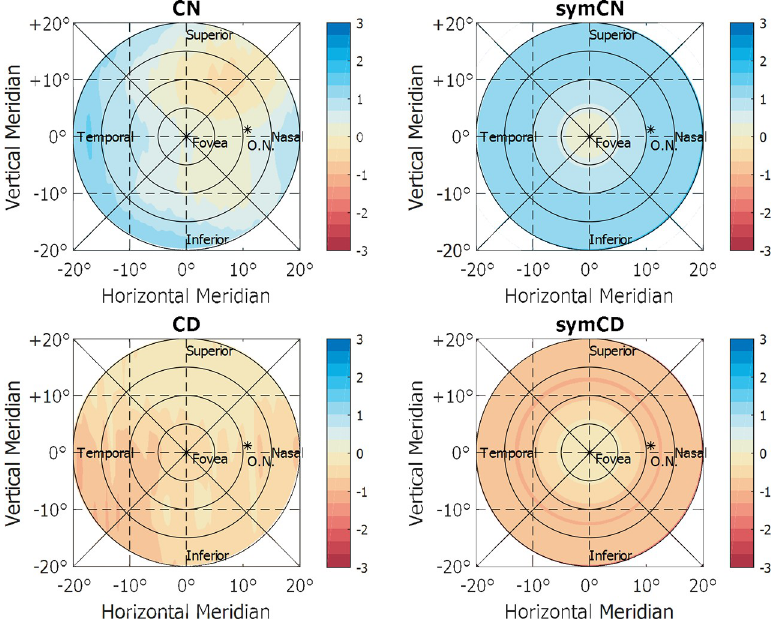
Fig 7. Computed, theoretical symmetric power profile of contact lenses, based on the values found in the measurements and the theoretical design of the contact lenses.